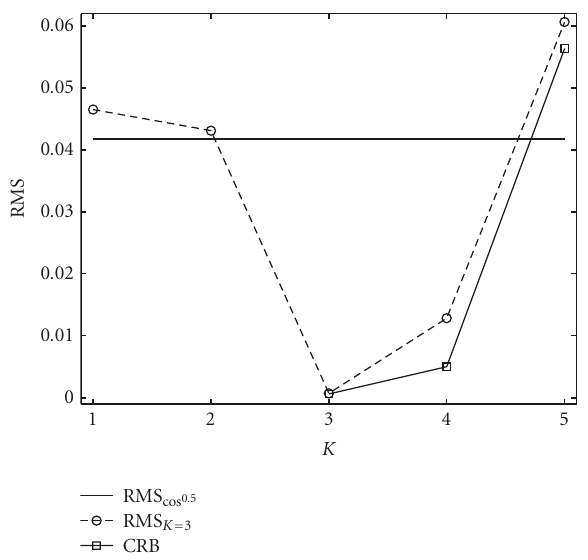
Figure 9: CRB and RMS based on Monte Carlo simulations when SNR is 30 dB. The true element factor is E true = cos2 θ , which means α = [0 0 1 0 0] or K = true true